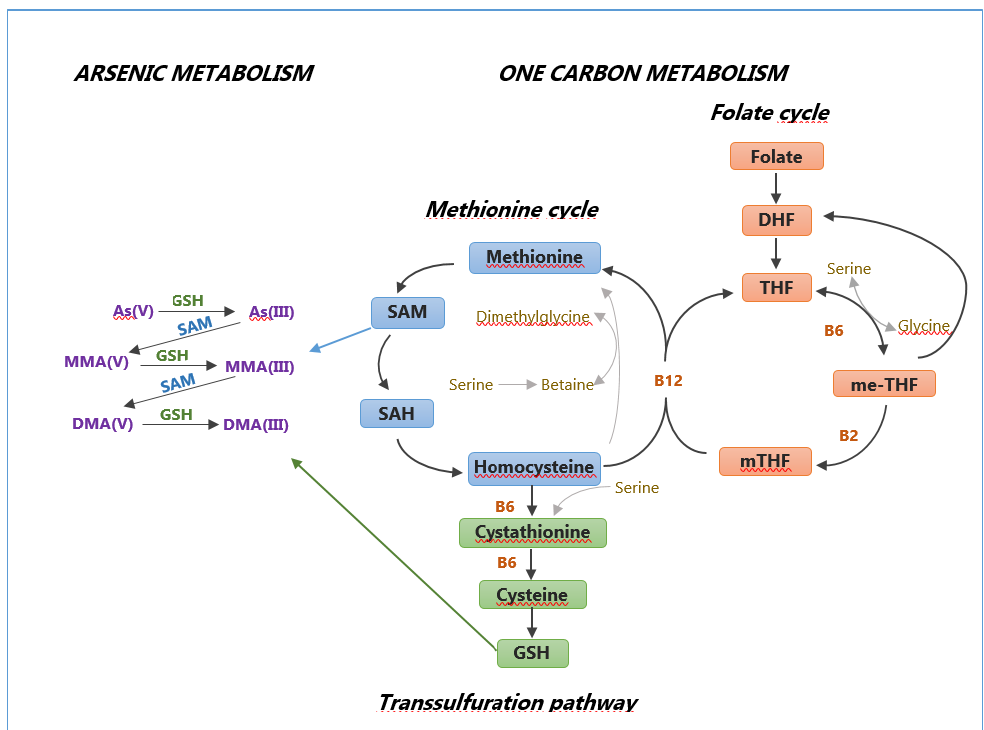
Figure 1. Interaction between one carbon metabolism and arsenic metabolism. Legend—As: